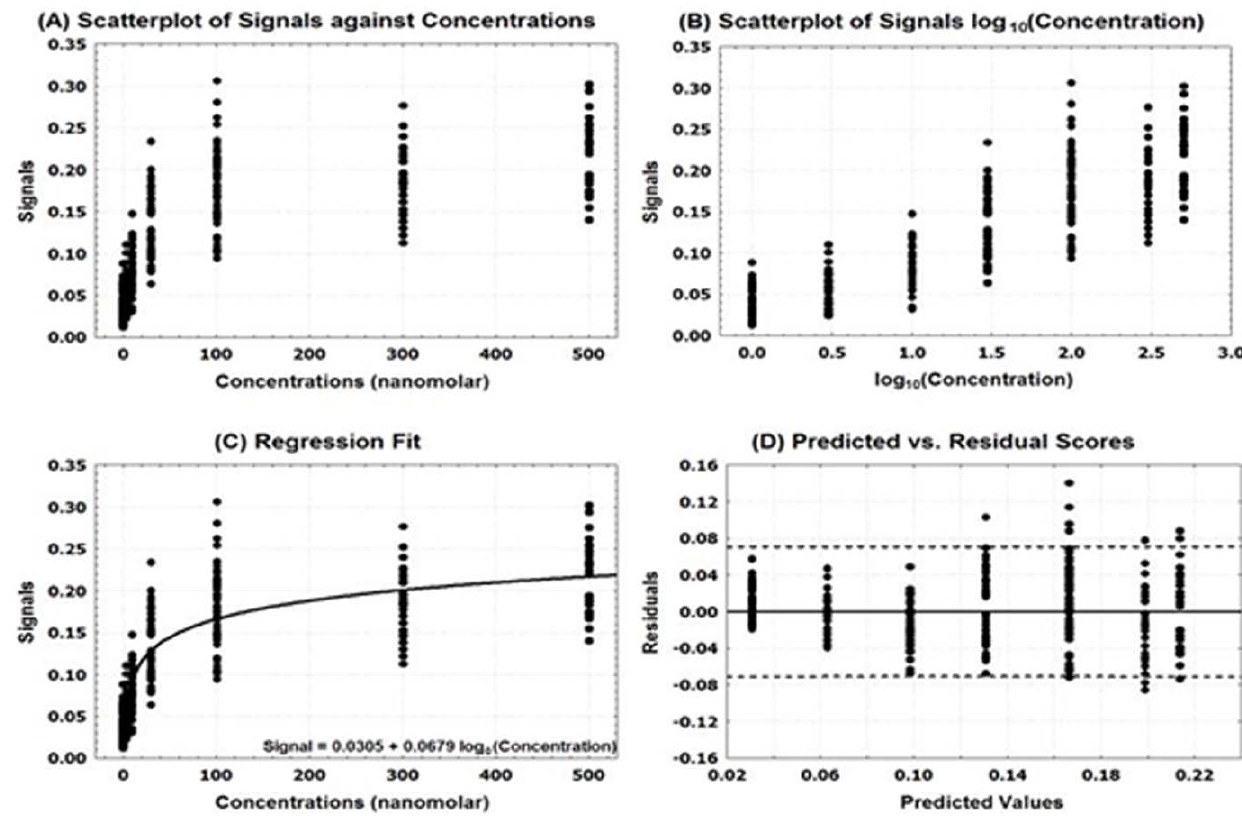
Figure 5. Linearity assessment for the V2R pharmacoperone assay. Using a pharmacoperone drug, the relation between the dose response and dose concentrations was evaluated.